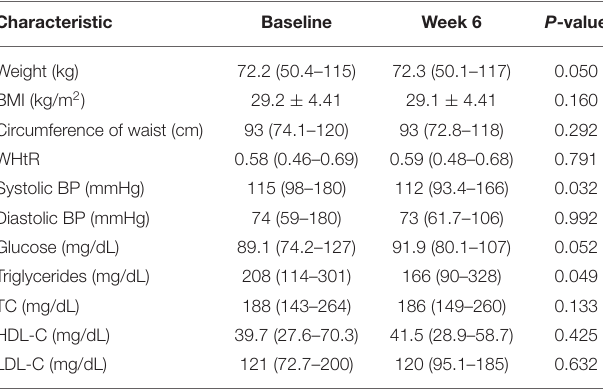
TABLE 2 | Anthropometric characteristics, blood pressure, and biochemical parameters at baseline and after intervention with Chaya. Characteristic Baseline